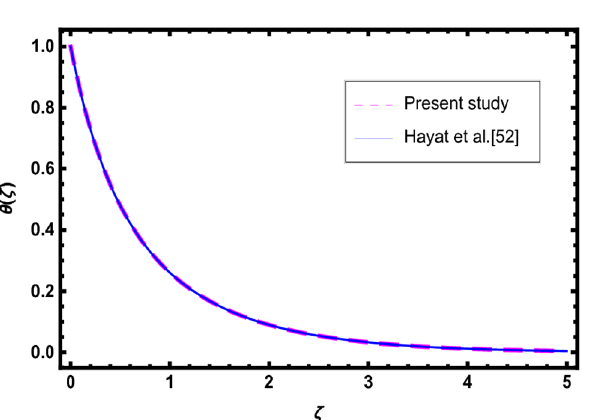
Figure 2. Comparison of the present work with the Hayat et al. 51 .